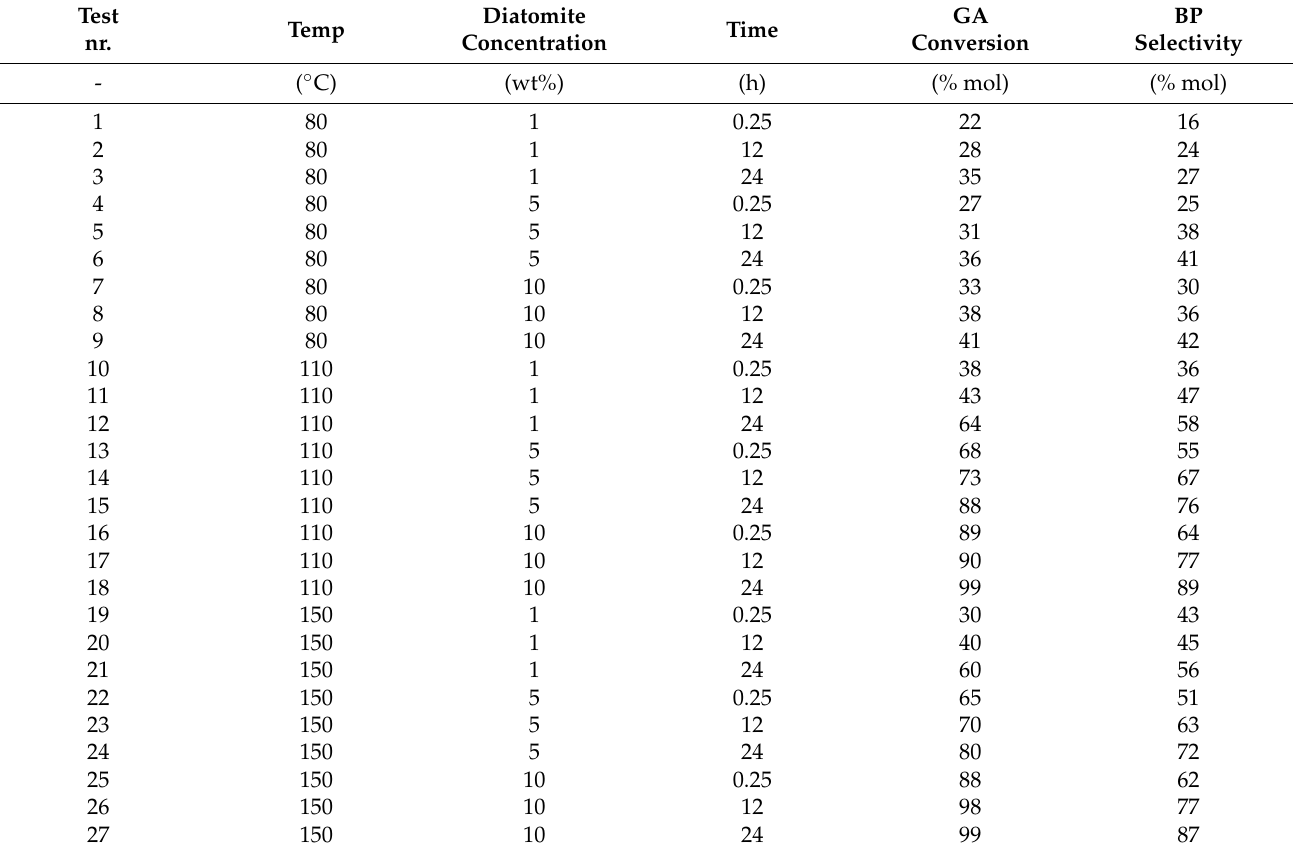
Table 4. Factors of the designed experiment.